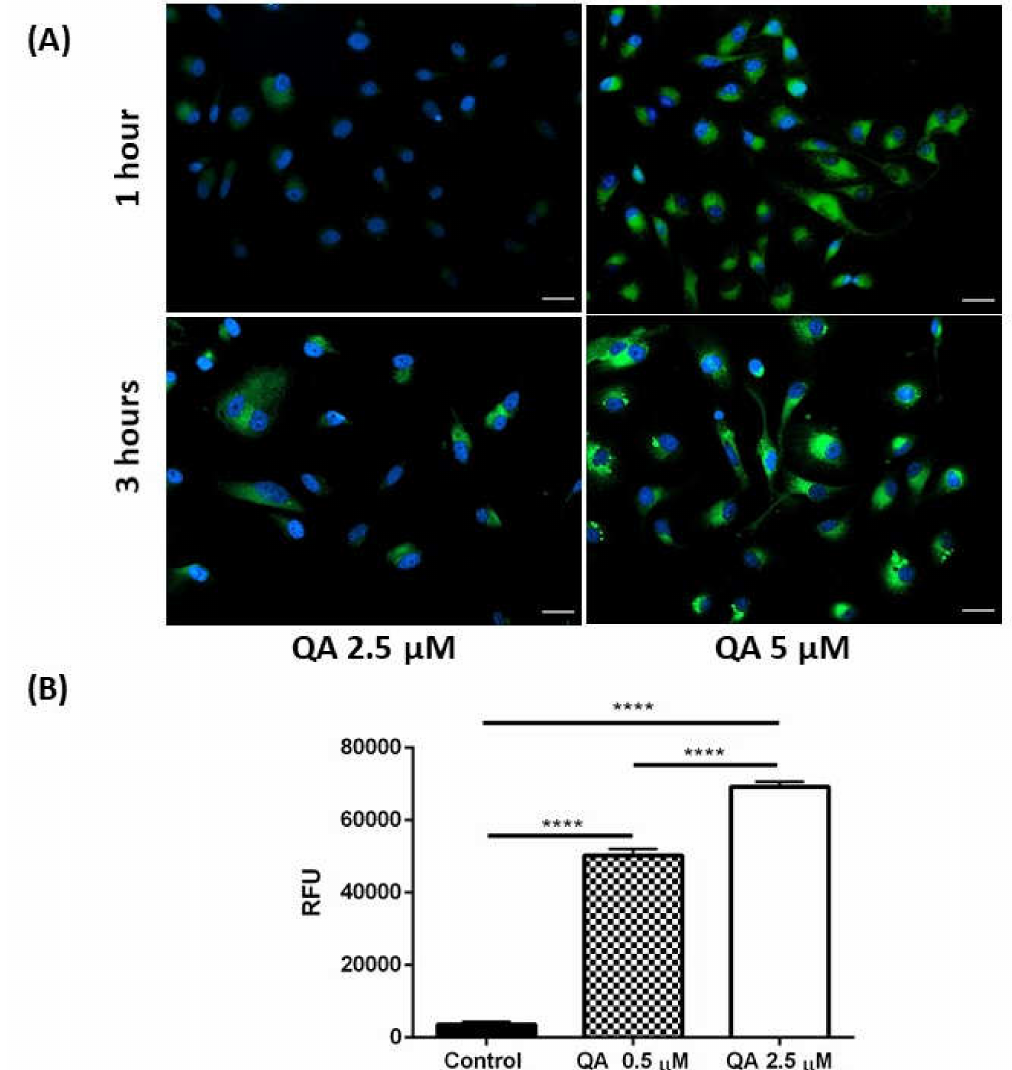
Figure 3. Evaluation of cellular internalization of QA by visual estimation and flow cytometry. ( A ) Cellular uptake study with QA (2.5- and 5- µ M)-treated H28 cells. Nucleus is stained blue with DAPI. QA is indicated in green owing to its inherent fluorescence. It can be seen that there is a concentration and time-dependent uptake of QA in H28 cells. Increase in concentration and exposure time increases the internalization of QA, represented by the increase in fluorescence intensity. ( B ) Plot represents fluorescence intensity (F.I.) of QA as measured using flow cytometer. Briefly, MSTO-211H cells (500,000 cells / well) were exposed to QA (0.5- and-2.5 µ M) for 3 h and F.I. was measured. A significant increase in F.I. is observed with increase in concentration. Data represents mean ± SD ( n = 3), **** p < 0.0001, compared between treatments and control groups, as indicated, Scale bar 100 µ